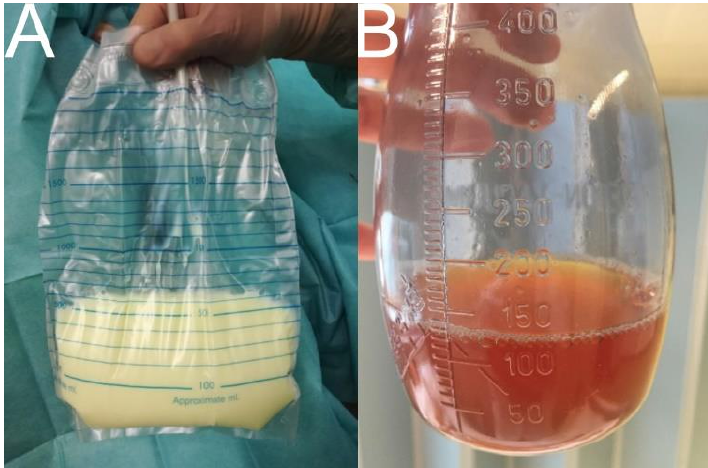
Figure 1. Drainage fluid in high-output and low-output lymphatic fistulas. Note: ( A ) chylothorax (6000 mL per day) with milky appearance if patient does not follow a fat-free diet (drainage fluid typically contains chylomicrons, triglycerides > 110 mg/dL, total fat 0.4–6 g/dL, total protein 22–60 g/L, and a total cell count >1000 cells/L with >80% leucozytes); ( B ) iliac lymphocele (300 mL per day) with amber color.